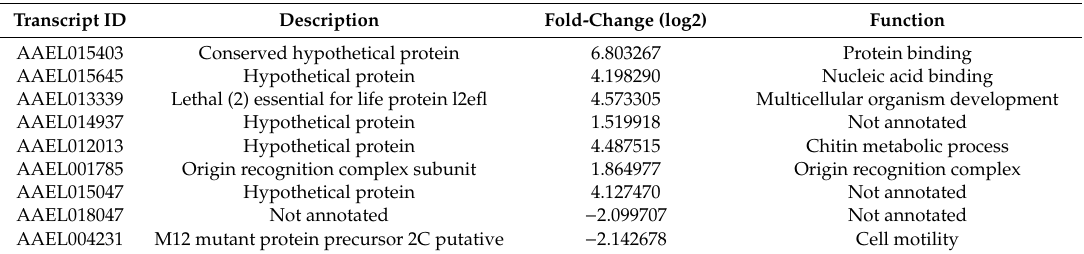
Table 5. Nine genes di ff erentially expressed between two field populations of Ae. aegypti .